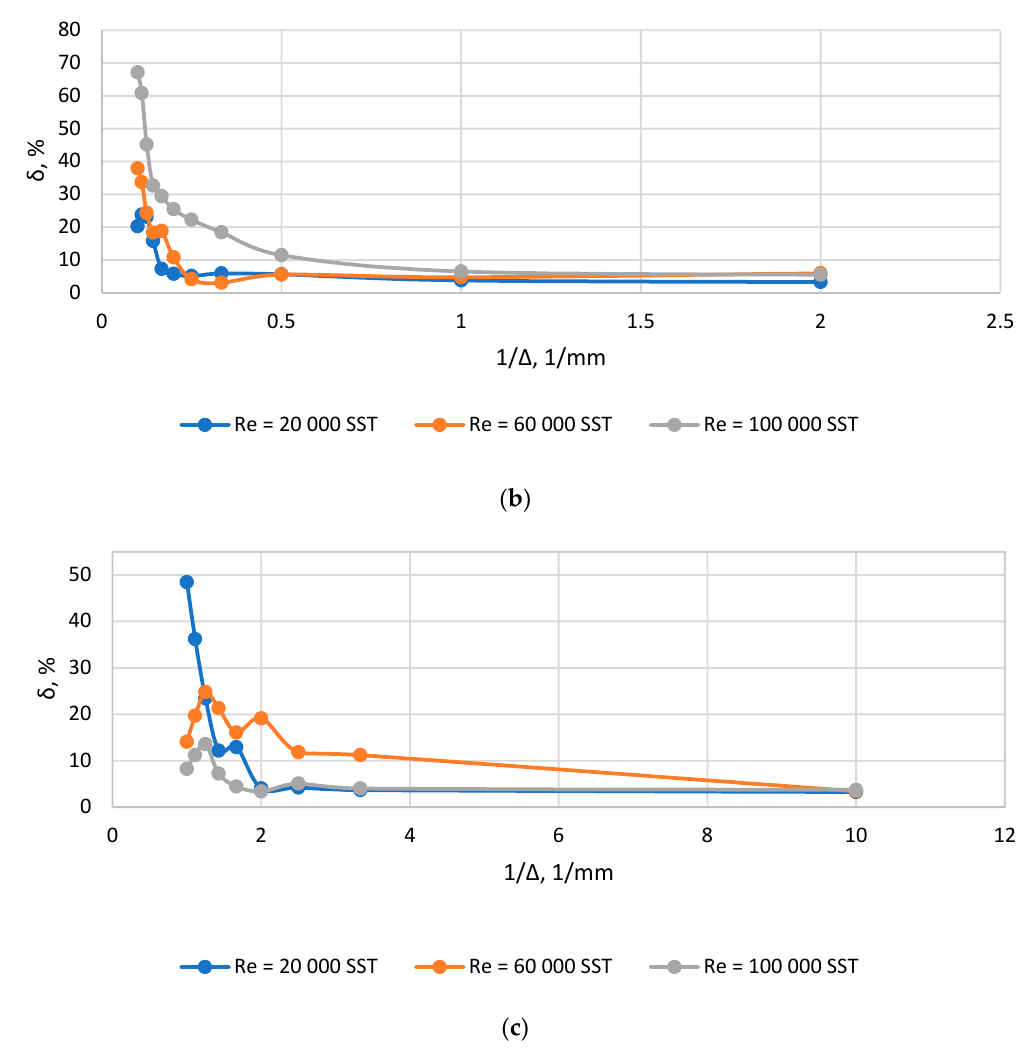
Figure 7. Plots δ (1/ Δ ) for diffuser: ( a ) F 0 /F 1 = 0.1; ( b ) F 0 /F 1 = 0.3; ( с ) F 0 /F 1 = 0.5.